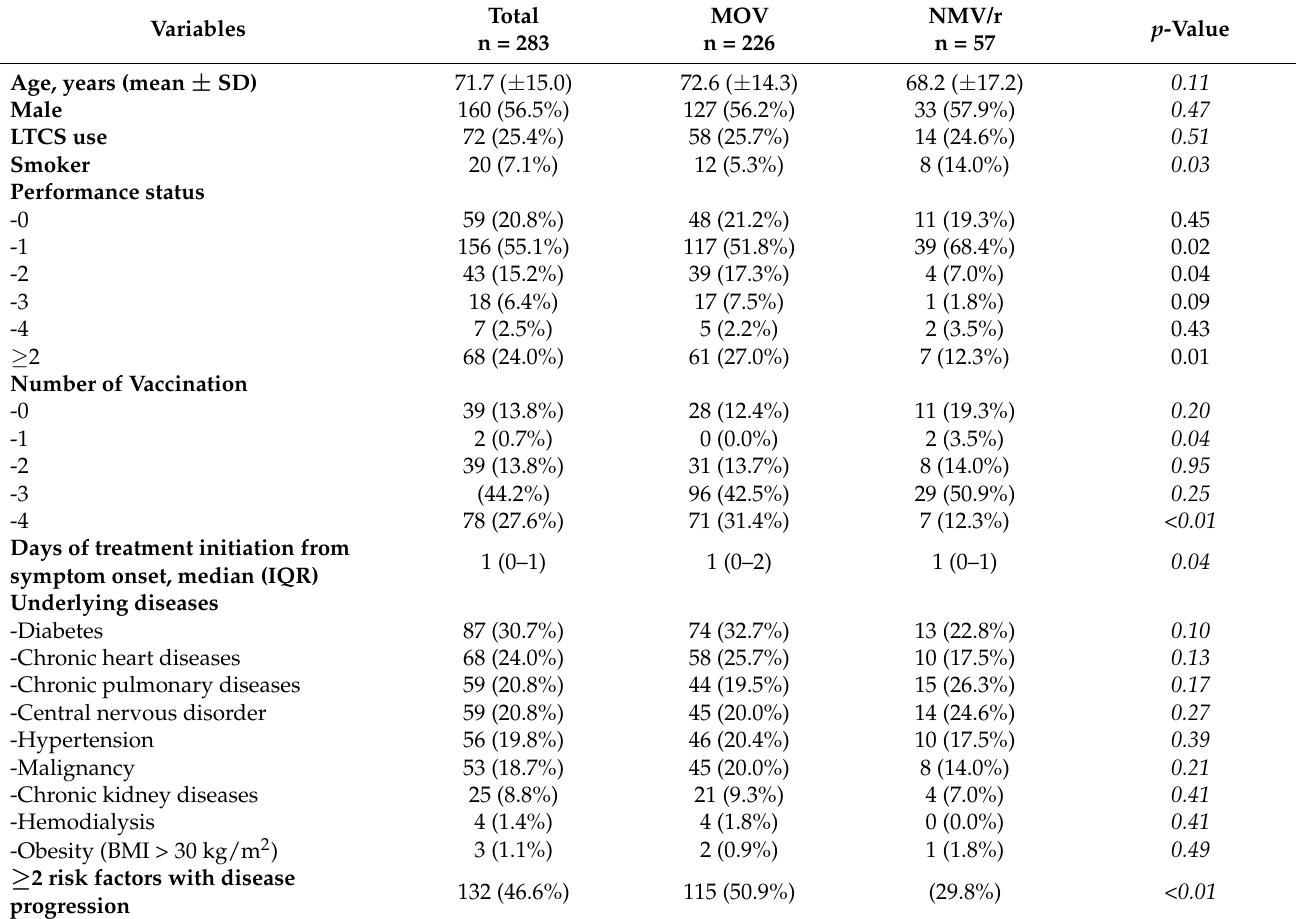
Table 1. Patient characteristics at the time of treatment initiation according to the drug